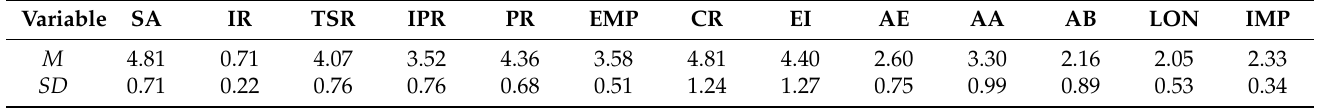
Table 9. Mean and standard deviation of